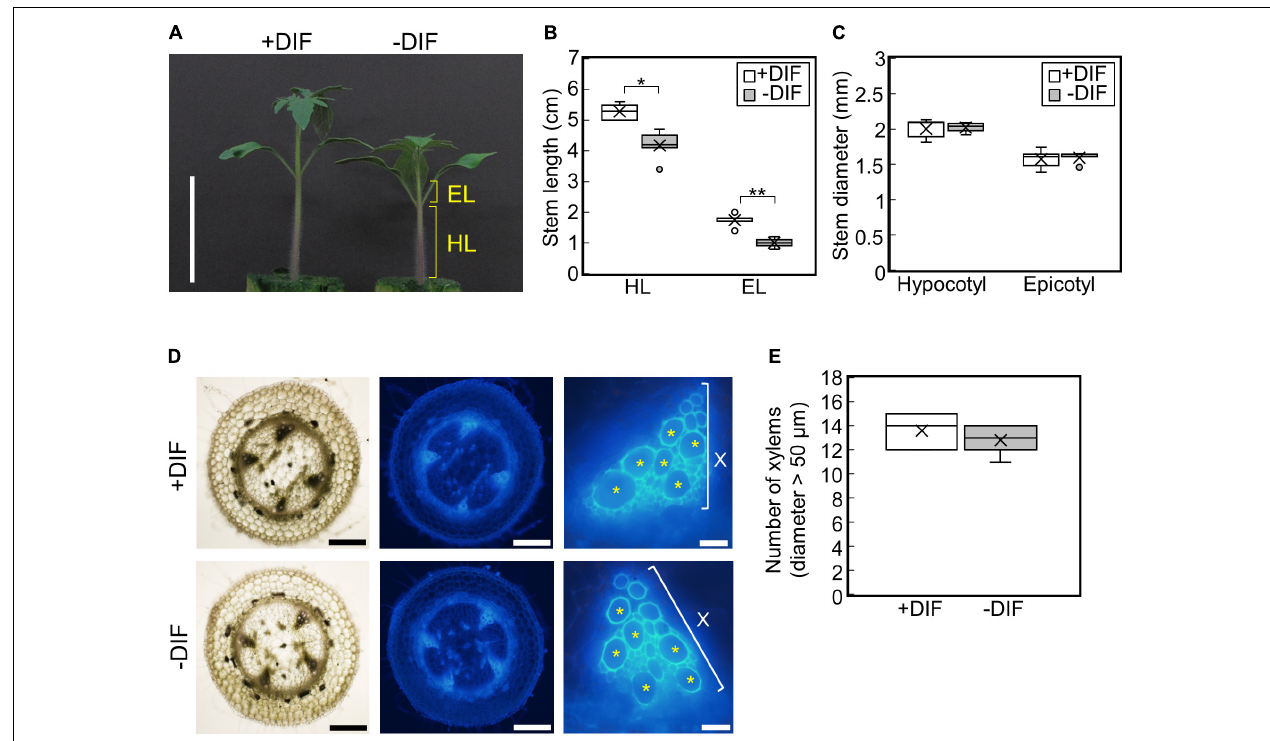
FIGURE 2 | Effect of DIF treatment on growth of tomato seedlings. Young tomato seedlings were grown for 7 days under 30 ◦ C/25 ◦ C (positive DIF) and 25 ◦ C/30 ◦ C (negative DIF). (A) , Growth of seedlings. Seedlings of tomato were photographed at 7 days. Scale bar = 5 cm. (B) , Hypocotyl and epicotyl length. (C) , Hypocotyl and epicotyl diameter. Data are shown as boxplots ( n = 5). (D) , Cross sections of hypocotyls. Asterisks indicate xylems (diameter > 50 µ m). Scale bars = 500 µ m (left and middle panels) and 50 µ m (right panels). (E) , Number of xylems (diameter > 50 µ m) in the cross section. Data are shown as boxplots ( n = 5). Cross marks in boxplot indicate the mean values. * P < 0.01; ** P < 0.001 (Student’s t test). +DIF, positive DIF; -DIF, negative DIF; HL, hypocotyl length; EL, epicotyl length; X, xylem